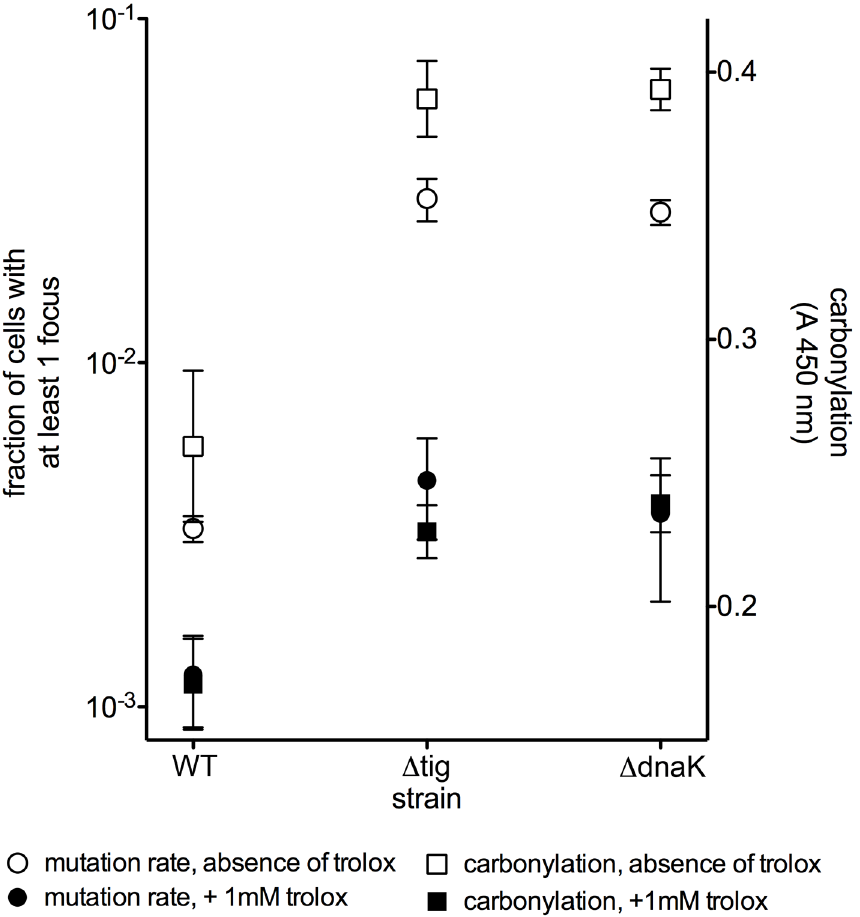
Figure 3. Trolox reduces the amount of protein carbonylation and the mutation rates. Parallel decrease in mutation rate (white and black circle) (fraction of cells with a MutL-CFP focus) and in constitutive protein carbonylation (white and black square) in the presence of 1 mM trolox (black symbols) relative to no trolox controls (white symbols). The results are given as mean of 3 measurements, each in triplicate. Error bars represent the standard deviation.